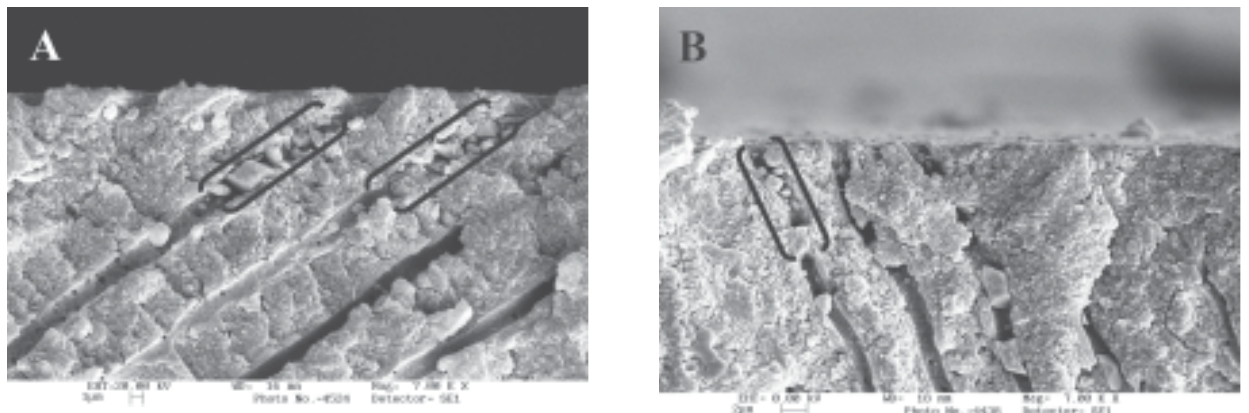
FIGURE 2- SEM micrograph of potassium oxalate-treated dentin. Note the crystal formation extending into the tubules. Areas between parentheses exhibit large formation of crystals within the dentin tubules. (A and B: x 7,000)